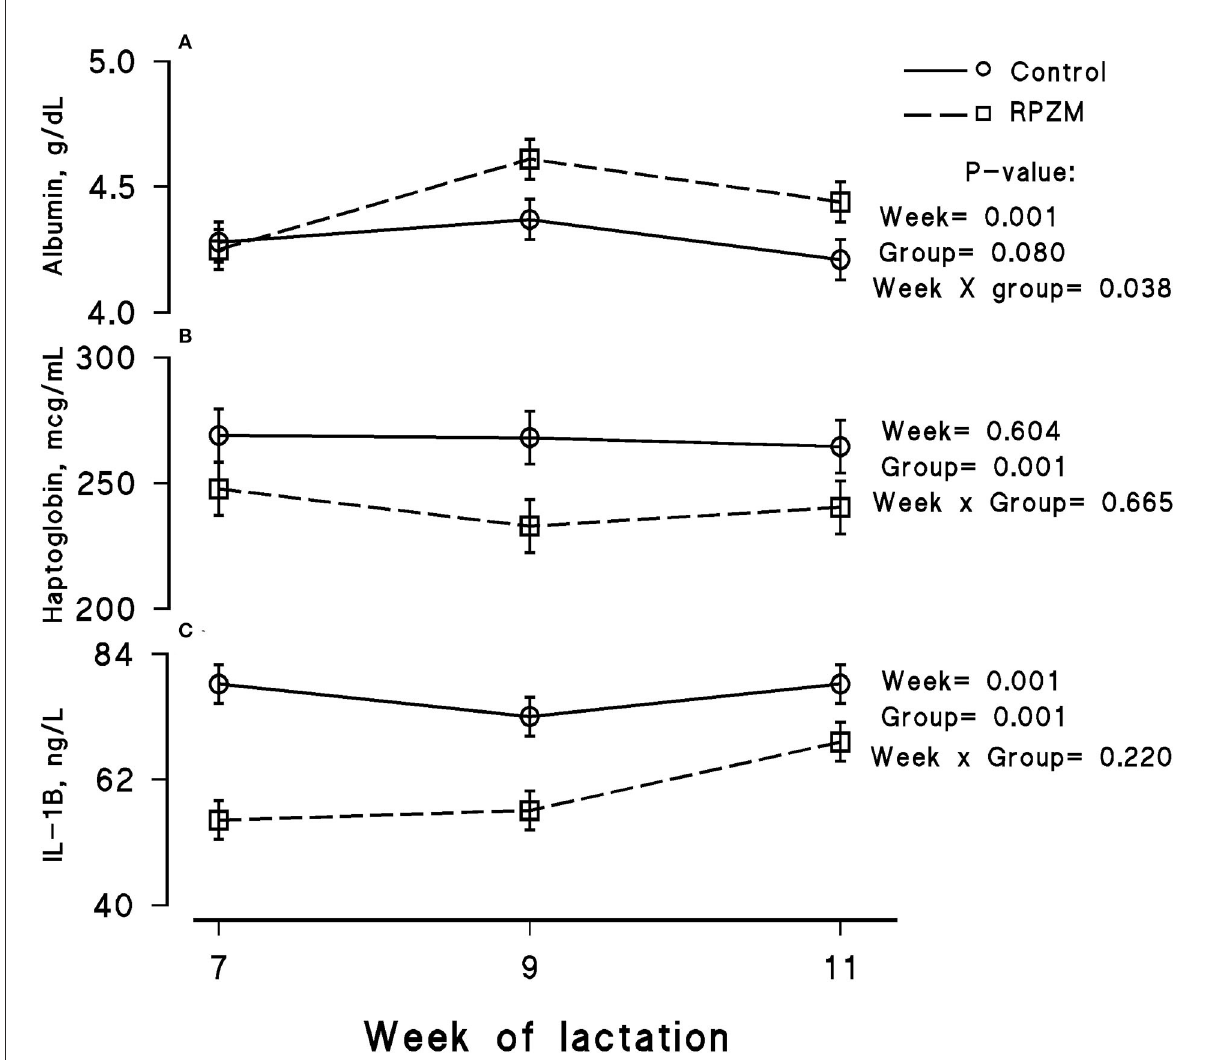
FIGURE6 Blood serum concentration of albumin (A) , haptoglobin (B) , and interleukin-1 beta (IL-1B; C ) of high-producing Holstein cows, through lactation weeks 6–11, supplemented without (control) or with rumen-protected zinc–methionine complex (RPZM) during long-term environmental heat stress. Values are means ± standard error of